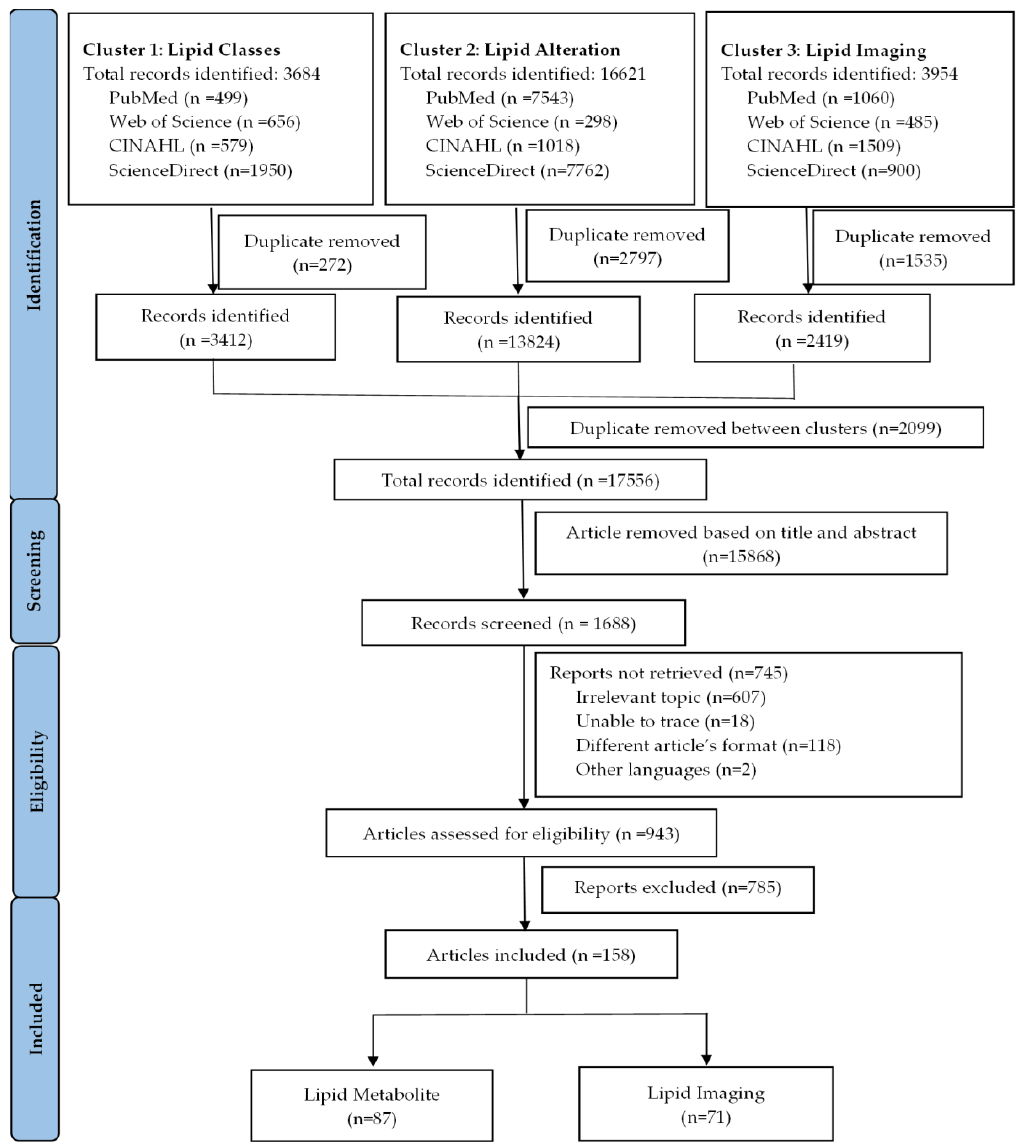
Figure 1. Flow diagram of study selection in the systematic review.